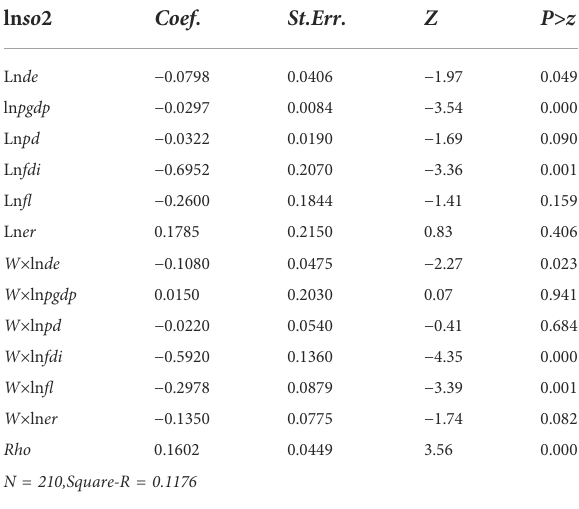
TABLE 9 Coef fi cients of the regression of the digital economy on industrial waste gases ln so 2